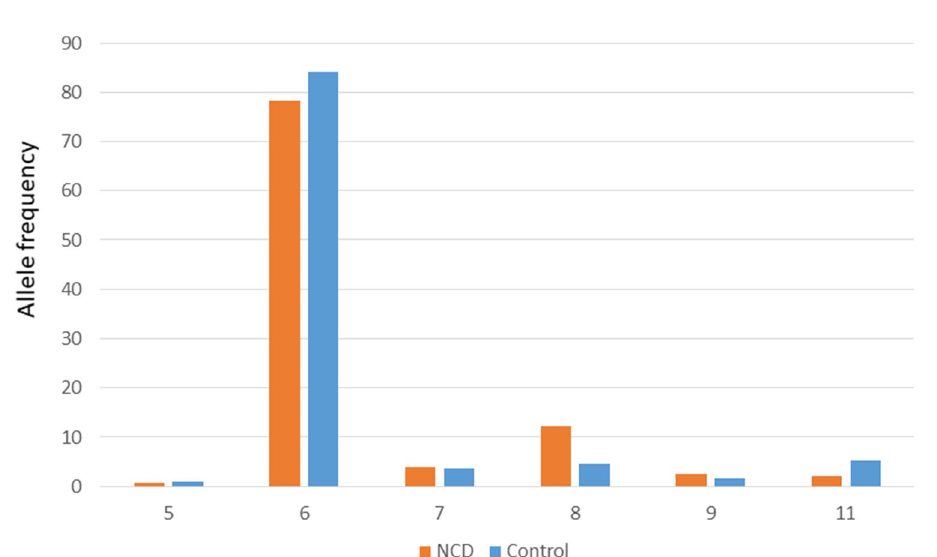
Figure 1. Electropherogram of the predominantly abundant allele at 6-repeats in the human RASGEF1C gene, in the context of a 6/6 genotype.